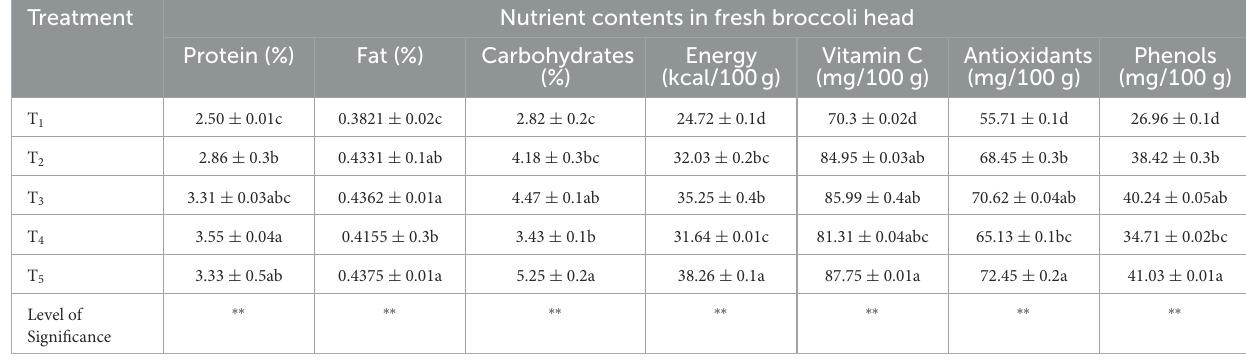
TABLE 2 Pre-harvest foliar application effect of mineral nutrient sources on nutrient content in fresh broccoli heads.